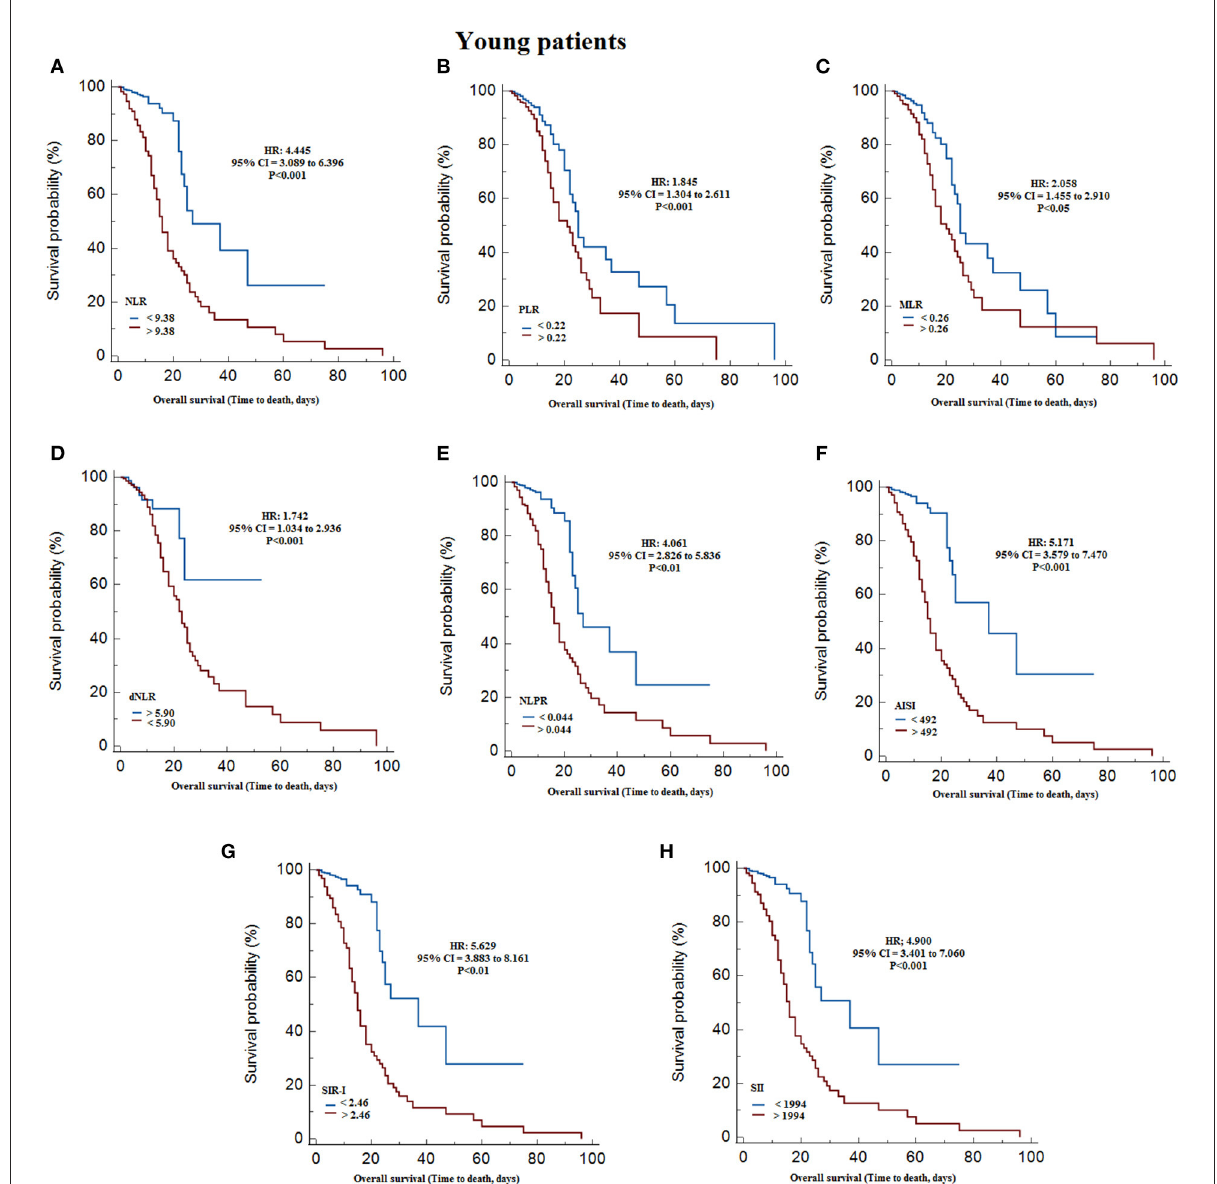
FIGURE2 Kaplan–Meier survival curves during hospitalization of non-elderly COVID-19 patients with different cut-off values of the systemic inflammation indexes investigated. (A) NLR; (B) PLR; (C) MLR; (D) dNLR; (E) NLPR; (F) AISI; (G) SIR-I; (H) SII. AISI, aggregate index of systemic inflammation; dNLR, derived neutrophil/lymphocyte ratio; MLR, monocyte/lymphocyte ratio; NLPR, neutrophil/lymphocyte*platelet ratio; NLR, neutrophil/lymphocyte ratio; PLR, platelet/lymphocyte ratio; SII, systemic inflammation index; SIR-I, systemic inflammation response index; WBC, white blood